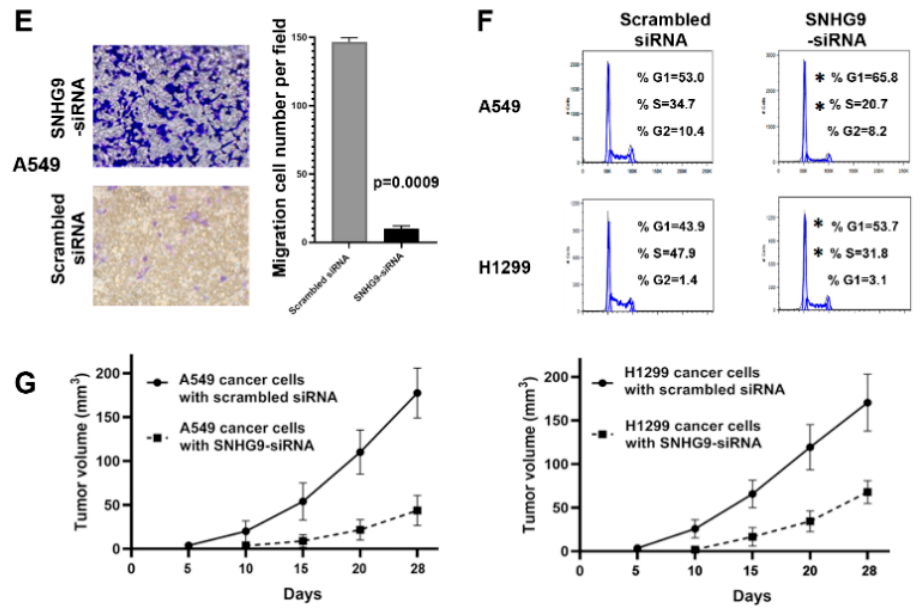
Figure 1. SNHG9 knockdown inhibits the tumorigenicity of A549 and H1299 lung cancer cells. ( A ) SNHG9 knockdown can significantly reduce cell viability by 72 h. The cell viability is determined by a cell viability assay using Cell Counting Kit 8 (Abcam); ( B ) SNHG9 knockdown can suppress cell proliferation in the cancer cells treated with SNHG9-siRNA; ( C ) SNHG9 knockdown significantly inhibits colony formation of cancer cells. The figure shows the results one week after the cells are seeded in the plates (34.8 mm diameter). ( D ) In the wound-healing assays, cancer cells transfected with SNHG9-siRNA show a slower gap closure compared with cells transfected with scrambled siRNA. The figure only shows the results of A549 cells from the time points 0 and 72 h, respectively. ( E ) Transwell migration assays show that SNHG9 knockdown can constrain migration and invasion of A549 cancer cells. The migratory cells are counted, and the results are expressed as the mean number of migratory cells ± SD / selected microscopic field ( n = 5). The number of migrated cells was evaluated by counting 5 random fields at × 50 magnification. The figure shows the results from the time point 24 h of A549 cells. ( F ) Knockdown of SNHG9 in lung cancer cells (A549 and H1299) elevates the percentage of the cancer cells in the G1 / G0 phase and reduces the percentage of S phase (*, p < 0.05). ( G ) Quantification of the tumor size over the time in vivo experiment shows that tumor growth in the mice injected with SNHG9-siRNA cancer cells (A549 and H1299) was significantly lower than in the mice injected with the cells transfected with scrambled siRNA. Tumor sizes (mean ± SD 3 ) were measured at the indicated intervals and